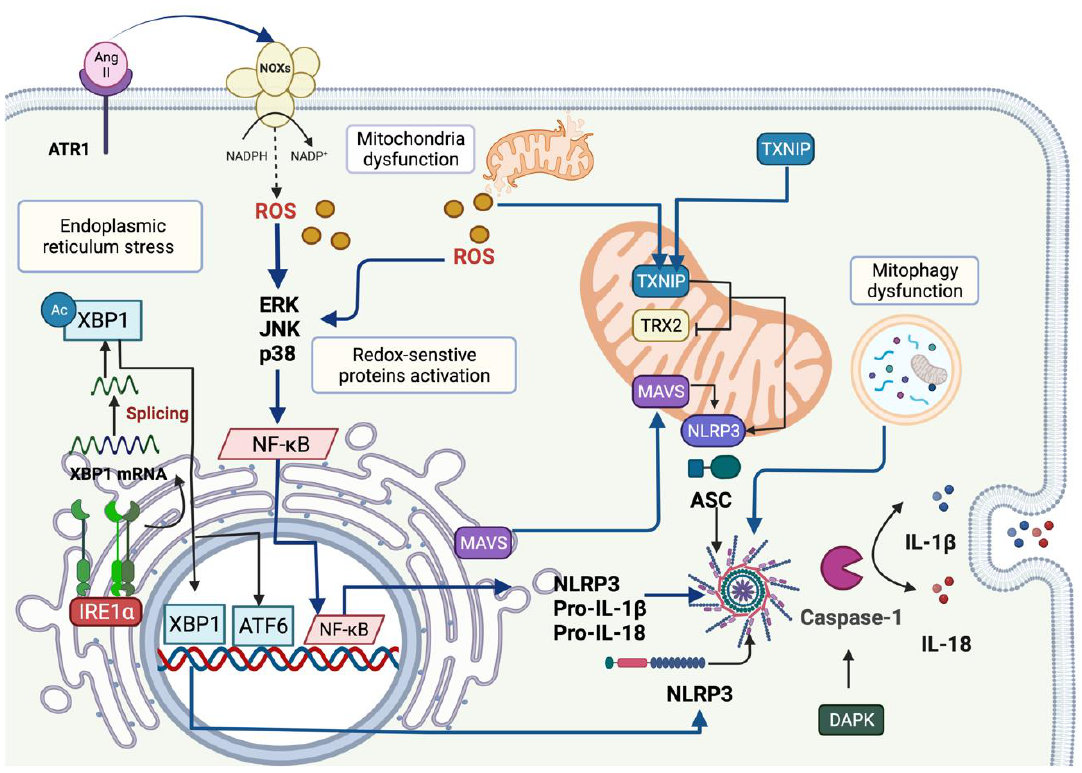
Figure 1. Activation of NOD-like receptor (NLR) family pyrin domain containing 3 (NLRP3) inflam- masome mediated by redox-signalling, mitochondria and ER-stress during acute kidney injury (AKI). The binding of angiotensin II (Ang II) to its receptor, the angiotensin receptor 1 (ATR1), triggers ROS overproduction by stimulating NADPH oxidases (NOXs) in the plasmatic membrane. The ROS produced by NOXs induces the activation of the redox-sensitive pathway, including extracellular signal-regulated kinase (ERK), c-Jun N-terminal kinases (JNK) and p38, proteins able to activate to nuclear factor κ -light-chain-enhancer of activated B cells (NF- κ B). The latter promotes the transcrip- tion of target genes such as NLRP3, pro-interleukin 1 β (IL-1 β ) and pro-interleukin 18 (IL-18). Under mitochondrial dysfunction, ROS are also generated, named mitochondrial ROS (mtROS), which activates the priming steps of inflammasome mediated by the redox-sensitive proteins. Further, ex- cessive mtROS leads to the translocation of thioredoxin-interacting protein (TXNIP) from the cytosol to the mitochondria. In mitochondria, TXNIP interacts with thioredoxin 2 (TRX2), inhibiting its activity, promoting the interaction with NLRP3 protein. Moreover, mitochondrial antiviral signalling protein (MAVS), an adaptor protein, is involved in NLRP3 localization in the mitochondria and participates in the inflammasome formation by promoting this interaction with apoptosis-associated speck-like protein containing a CARD (ASC). High levels of mtROS activate mitophagy, a negative regulator of inflammasome; however, in the case of AKI, mitophagy is dysfunctional, contributing to NLRP3 inflammasome activation. Another protein that activates inflammasome is death-associated protein kinase (DAPK), which activates caspase-1. On the other hand, the endoplasmic stress reticu- lum produces ROS and triggers unfolded protein response (UPR), recognized as an inductor of the inflammasome. Figure created using BioRender (Toronto, ON,